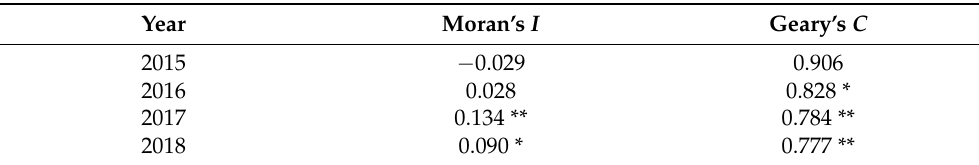
Table 2. Moran’s I and Geary’s C statistics of the PPP project implementation rate from 2015 to 2018 (source: authors’